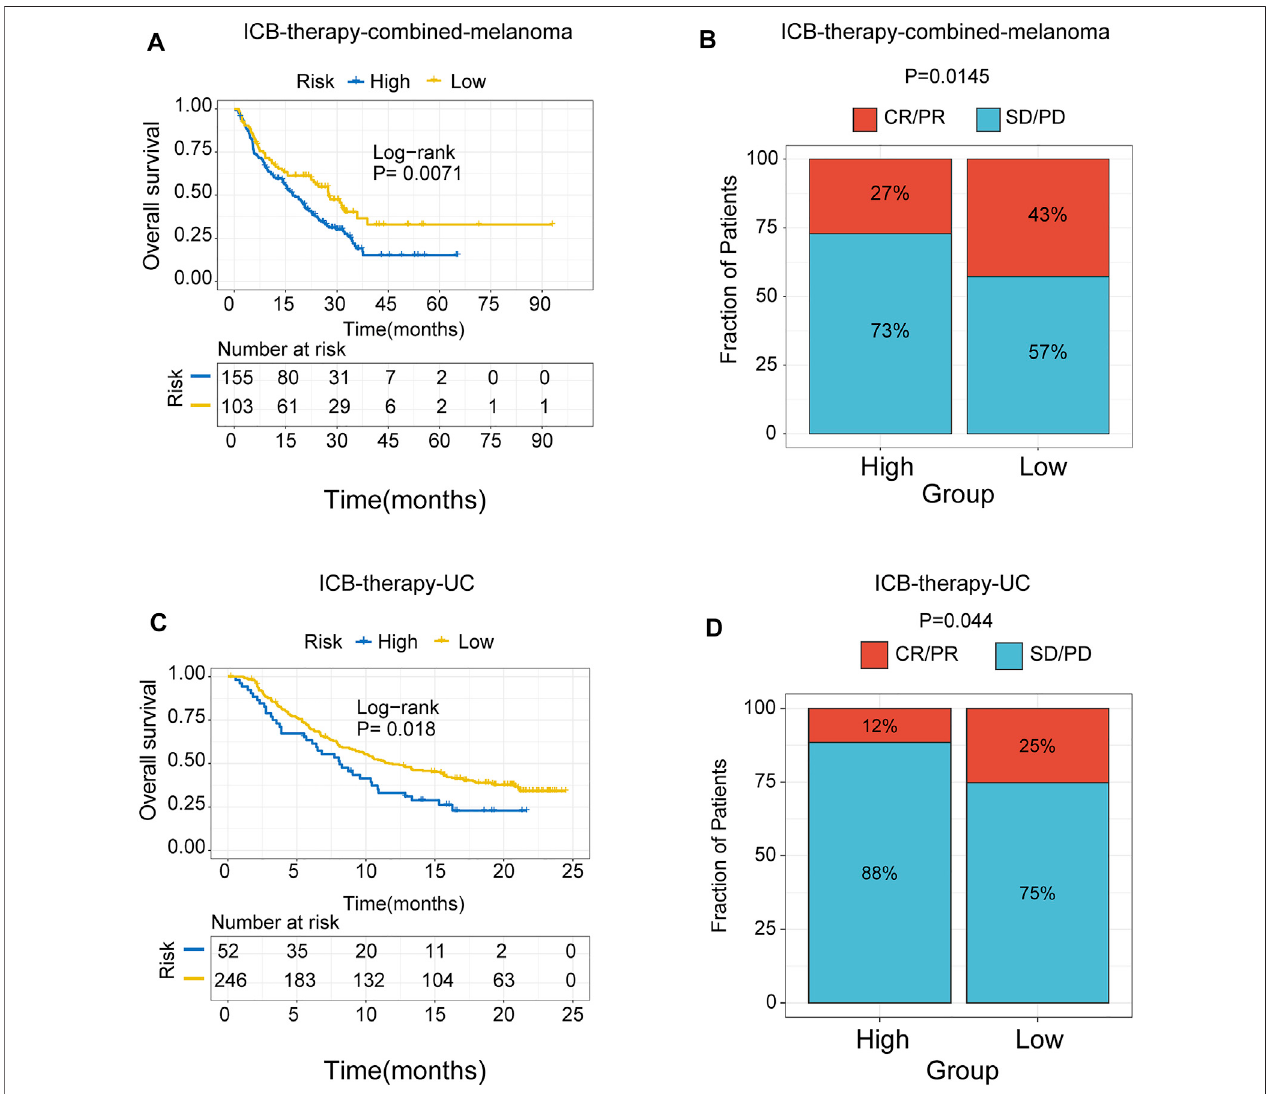
FIGURE 8 | The role of risk signature in ICB therapy cohorts. Kaplan Meier plots of patients treated with immune checkpoint blockade. (A) ICB-therapy-combined melanoma. (B) ICB-therapy-UC.Thedegreeofimmunecheckpointblockadetherapyresponseinhigh-andlow-riskgroups. (C) ICB-therapy-combinedmelanoma. (D) ICB-therapy-UC. CR, complete response; PR, partial response; SD, stable disease; PD, progressive disease.